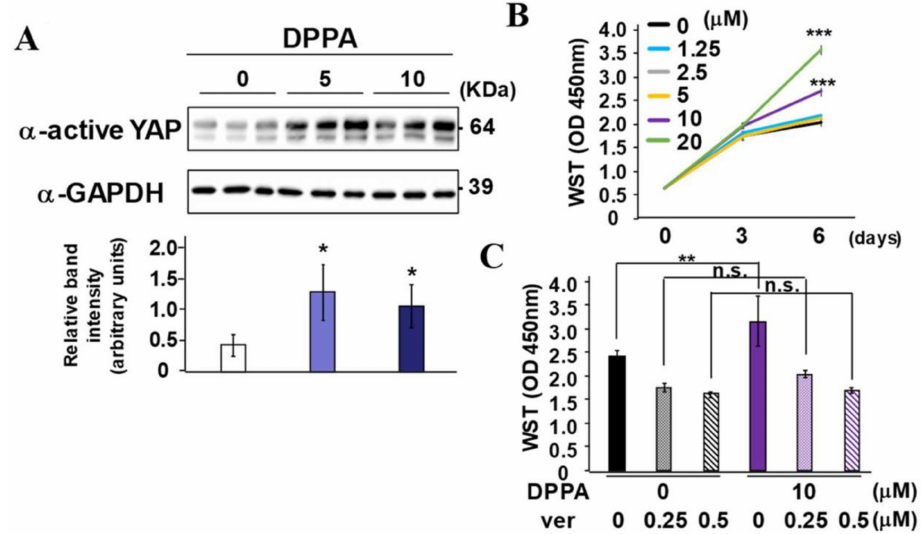
Figure 5. DPPA activates YAP and promotes cell proliferation in vitro. ( A ) PDLF were cultured in the presence of DPPA for 24 h, and the YAP activation was analyzed by SDS-PAGE using GAPDH as the loading control. ( B ) PDLF were cultured in various concentrations (0, 1.25, 2.5, 5, 10, and 20 µ M) of DPPA for 6 days, and the number of cells was counted. ( C ) PDLF were cultured with DPPA (10 µ M) in the presence of verteporfin (0, 0.25, and 0.5 µ M) for 6 days, and the number of cells was counted. * p < 0.05; ** p < 0.01; *** p < 0.001 significantly higher than the cells in the absence of DPPA ( B ) and lower than the cells in the absence of verteporfin ( C ). n.s. = not significant. ver =